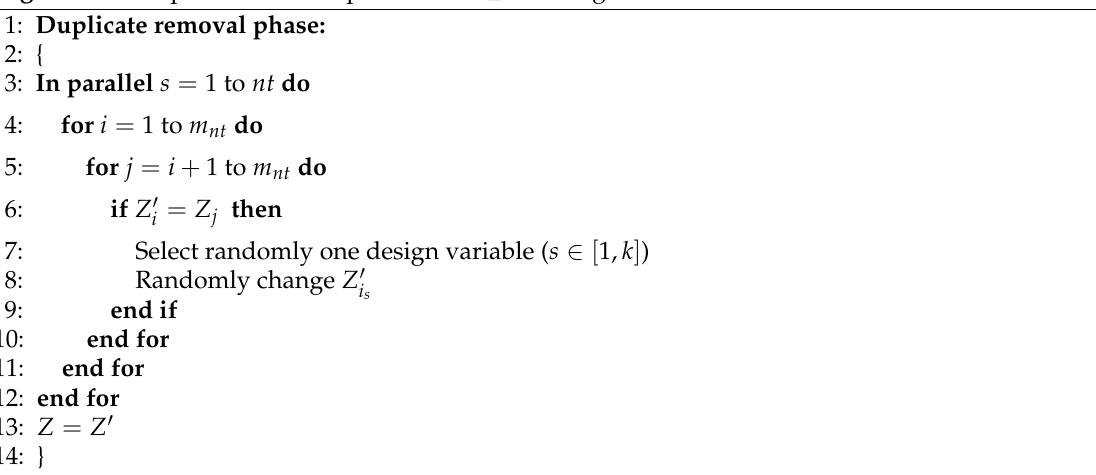
Algorithm 9 Duplicate removal phase of SPP_TLBO